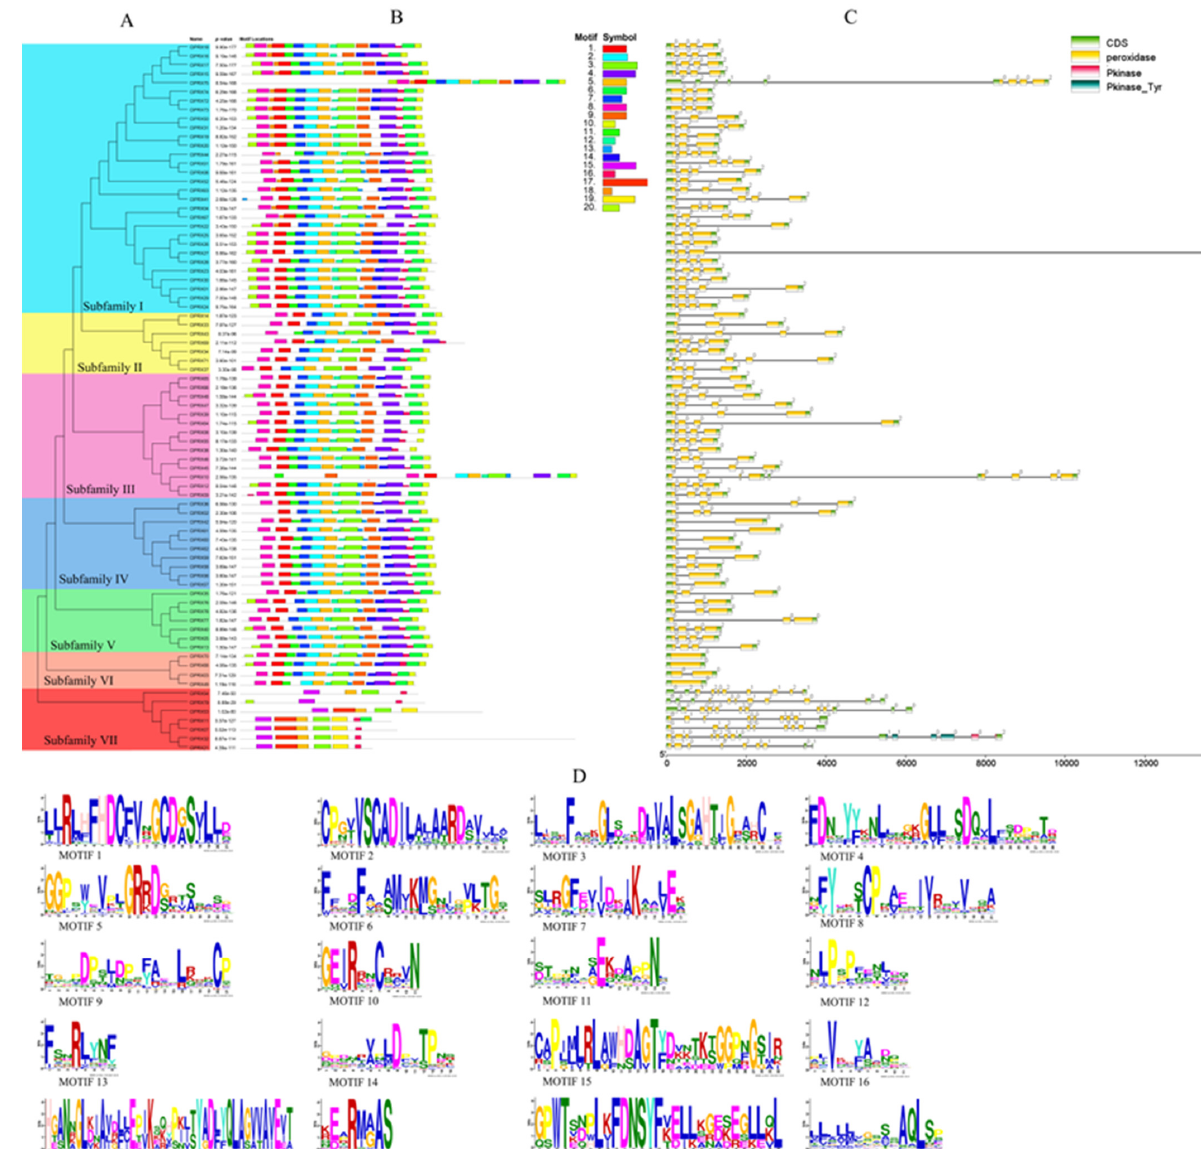
Figure 3. Constructed phylogenetic tree, gene structure, and conserved protein structure of ClPRXs. ( A ) Intraspecific evolutionary tree of ClPRX members. ( B ) The distribution of conserved motifs of ClPRX proteins. ( C ) The intron–exon structure and functional domain of the conserved structure of ClPRXs. ( D ) The conserved motifs of ClPRX proteins.